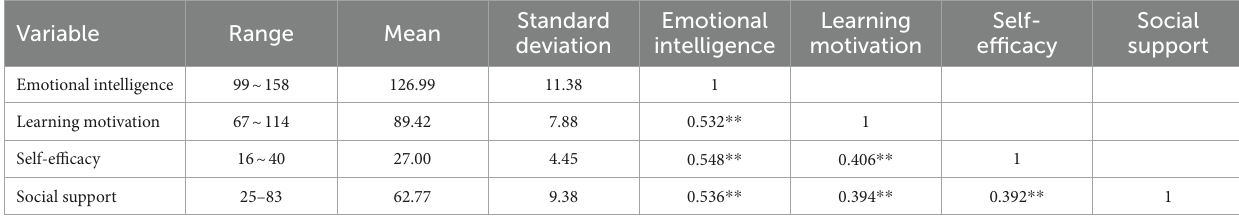
TABLE 3 Range, mean score, standard deviation, and correlation between variables for each scale score.